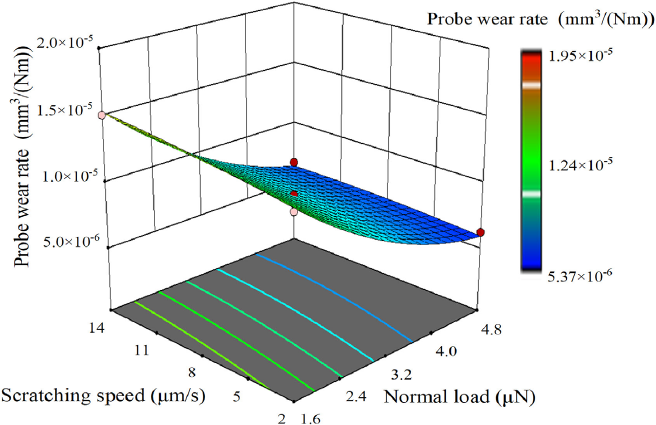
Figure 15. Three-dimensional response surface of probe wear rate .